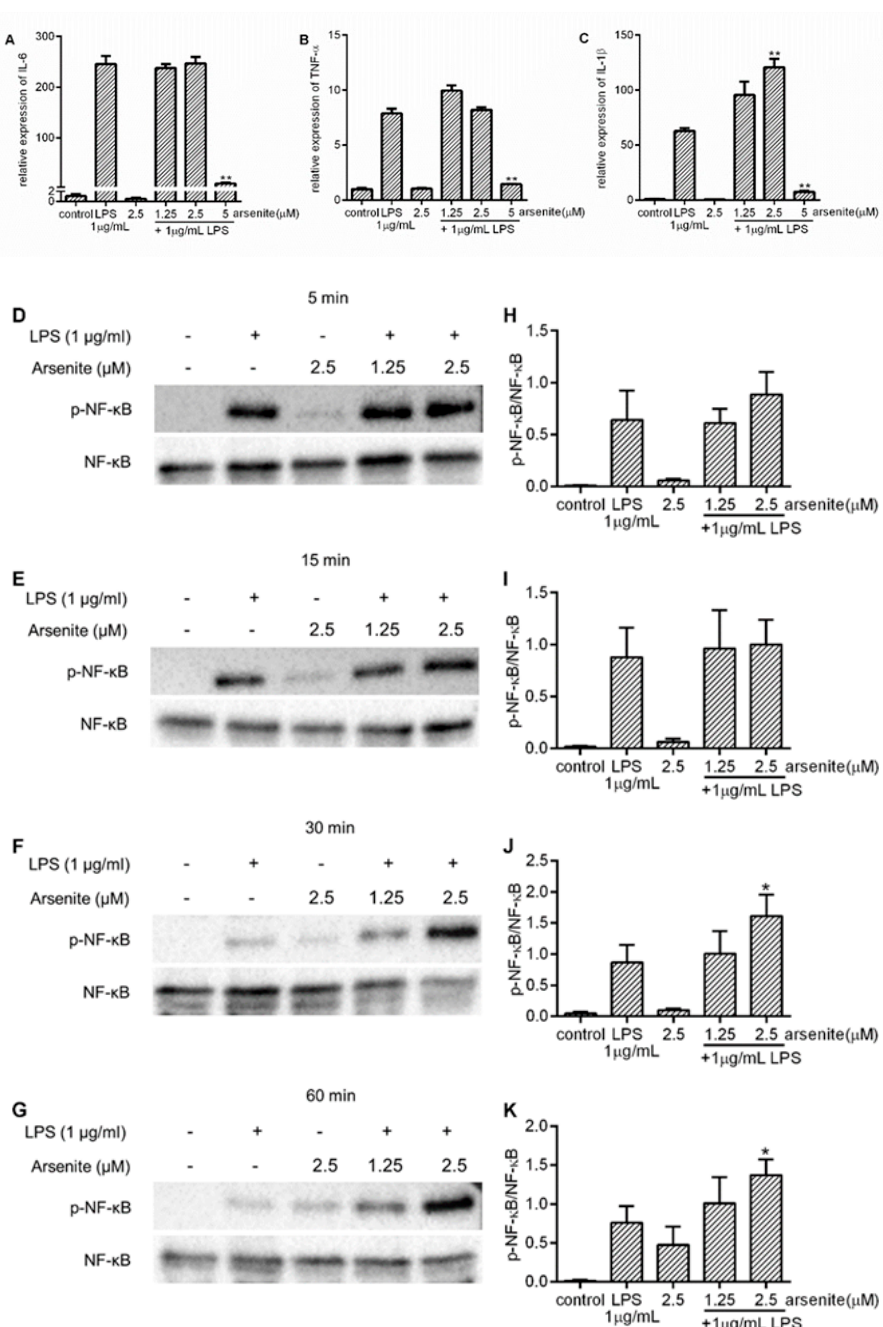
Figure 6. The e ff ect of a deficiency of inducible Hsp70 on pro-inflammatory cytokine expression and NF- κ B phosphorylation. Hsp70 knockout 030D cells were treated with di ff erent concentrations (1.25, 2.5 or 5 µ M) of arsenite, or without, for 16 h, and then exposed to LPS. The cells were harvested after 6 h ( A – C ) of LPS exposure. qPCR was performed to detect the expression of IL-6 ( A ), IL-1 β ( B ) and TNF- α ( C ). For Western Blotting, the cells were harvested after 5 ( D , H ), 15 ( E , I ), 30 ( F , J ) and 60 ( G , K ) min of LPS exposure. Western Blotting was performed to detect levels of phosphorylated NF- κ B and total NF- κ B at certain time points. The densitometry of the protein bands was scanned and quantitated with Image lab TM software 6.0.1. ( H – K ). The total NF- κ B levels were used as an internal control. Data are shown as the mean ± SD and are representative of three independent experiments. * p < 0.05, ** p < 0.01 vs. LPS alone